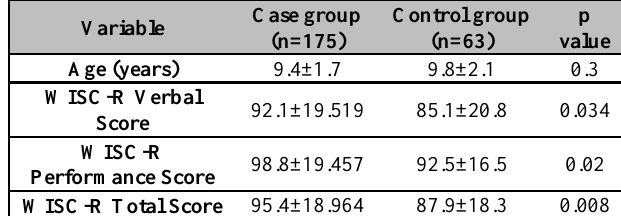
Table 3: Comparison of WISC-R scores between the